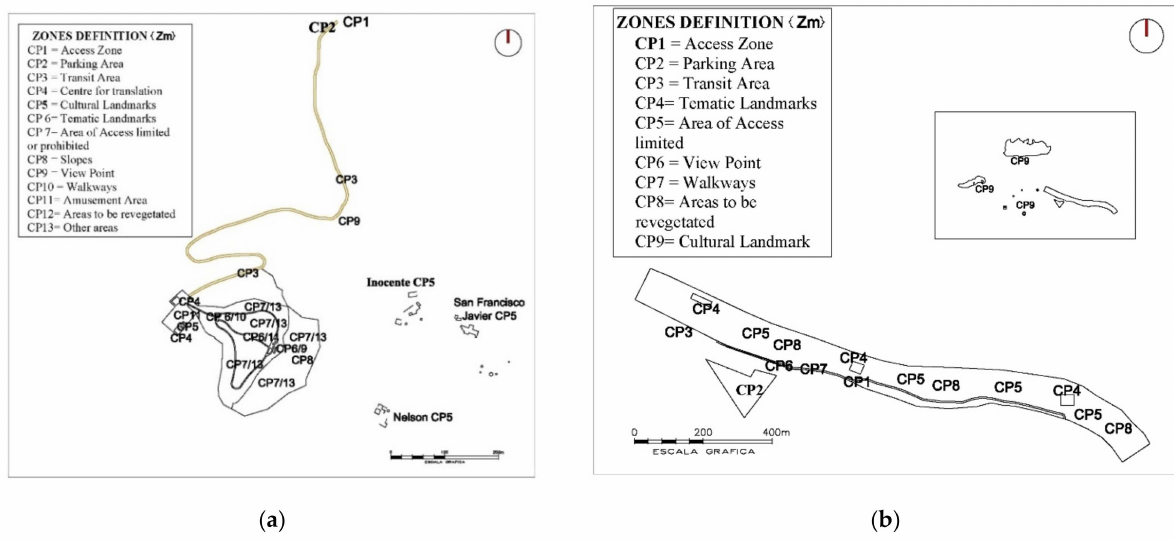
Figure 5. Definition of landscape typologies selected and location in map for: ( a ) Case Study 1, and ( b ) Case Study